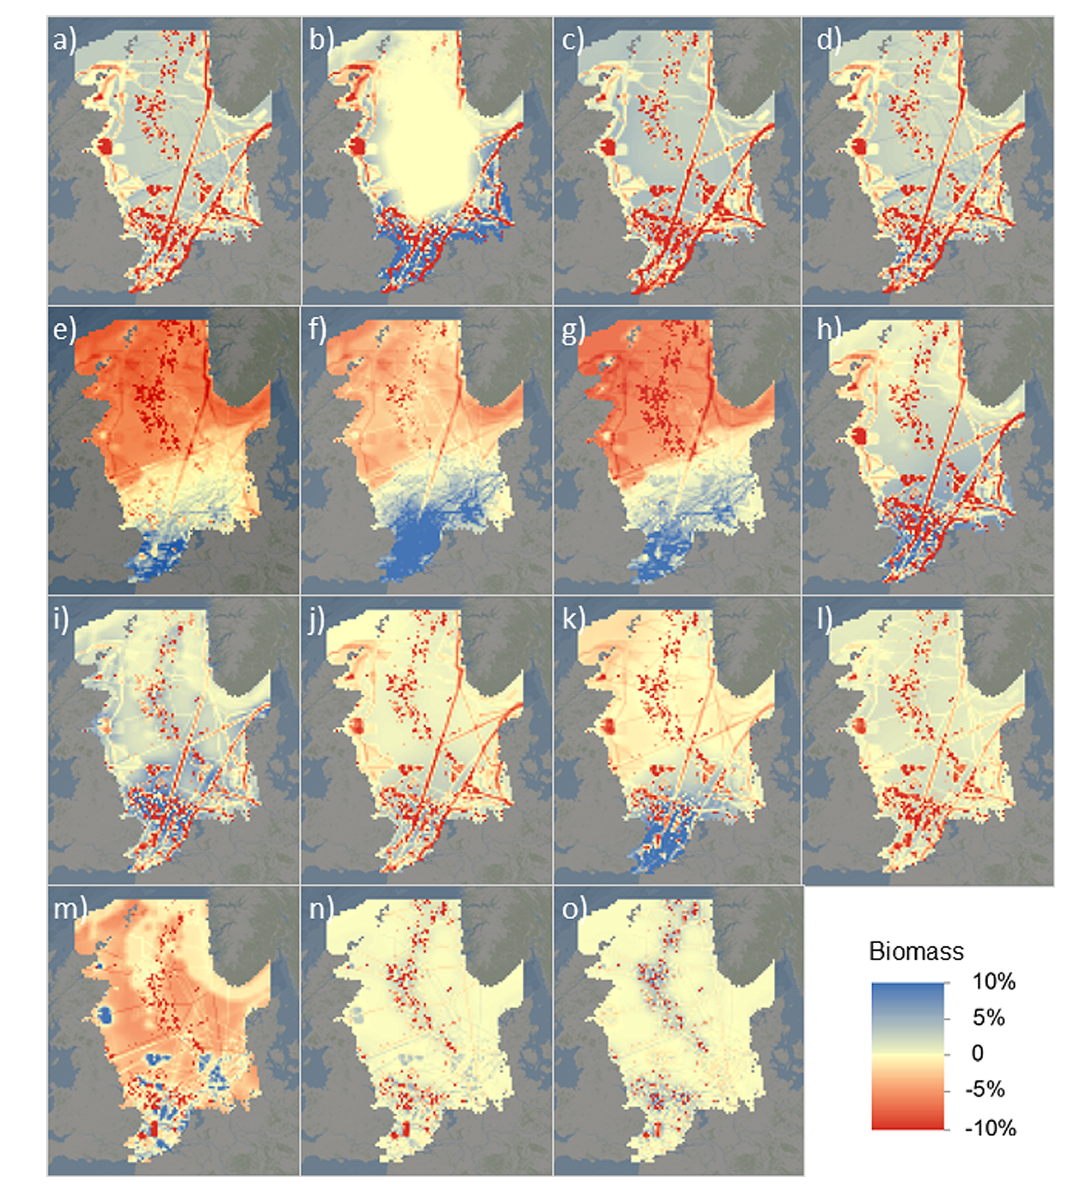
Fig. 5. North Sea biomass distribution and intensity changes up to 10% in response to the introduction of marine spatial planning start-up pressures after a 40-yr simulation period for various biological compartments. (A) Cetaceans. (B) Seals. (C) Windfarm-avoiding seabirds. (D) Windfarm-indifferent seabirds. (E) Cod. (F) Commercial gadoids. (G) Demersal predators. (H) Herring. (I) Sandeel and sprat. (J) Mackerel. (K) Flatfish. (L) Large demersal fish. (M) Large crabs. (N) Large benthic invertebrates. (O) Small benthic